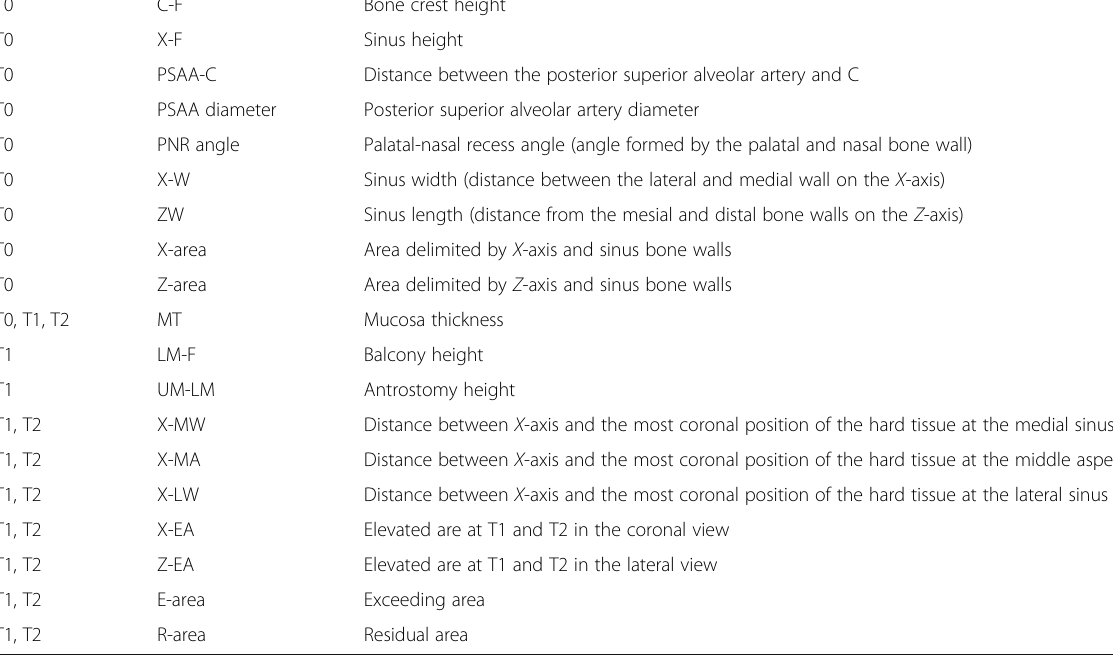
Table 1 Measurements performed on the CBCTs at the various periods of evaluation